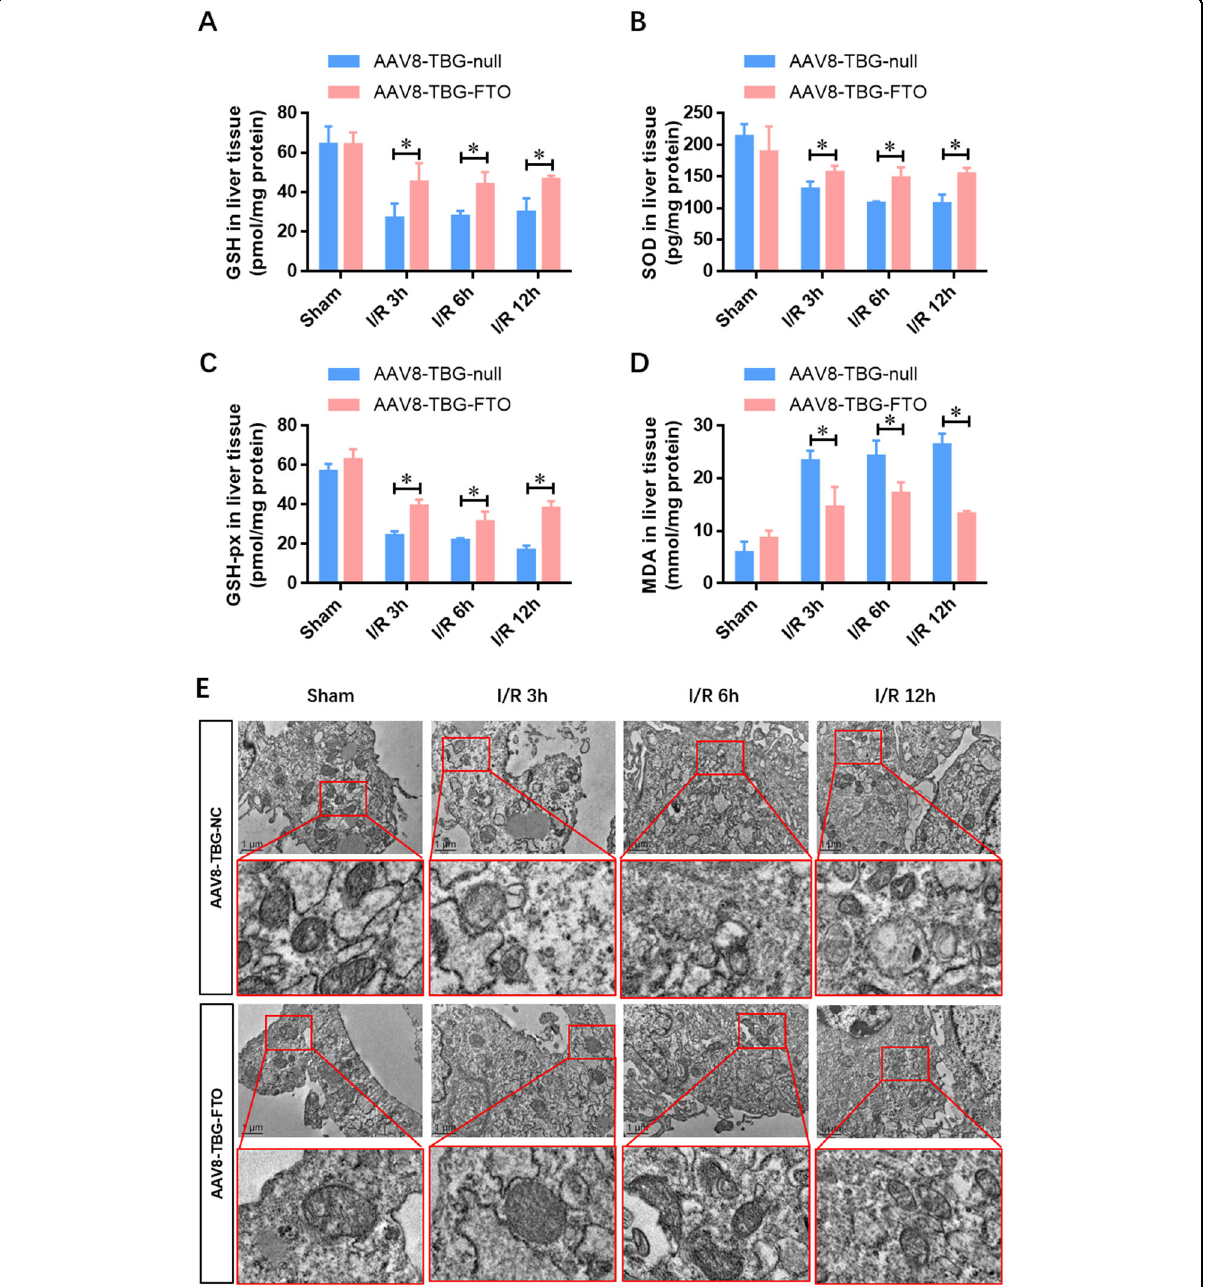
Fig. 3 Liver-speci fi c overexpression of FTO alleviates liver oxidative stress and mitochondrial fragmentation in vivo. A – D Tissue levels of GSH, GSH-Px, SOD, and MDA were detected using ELISA at indicated time points after reperfusion. E Representative electron microscope photos of the mitochondria in the hepatic tissues infected with control AAV8-TBG-null and AAV8-TBG-FTO during IRI. N = 5; * P < 0.05 vs. AAV8-TBG-NC